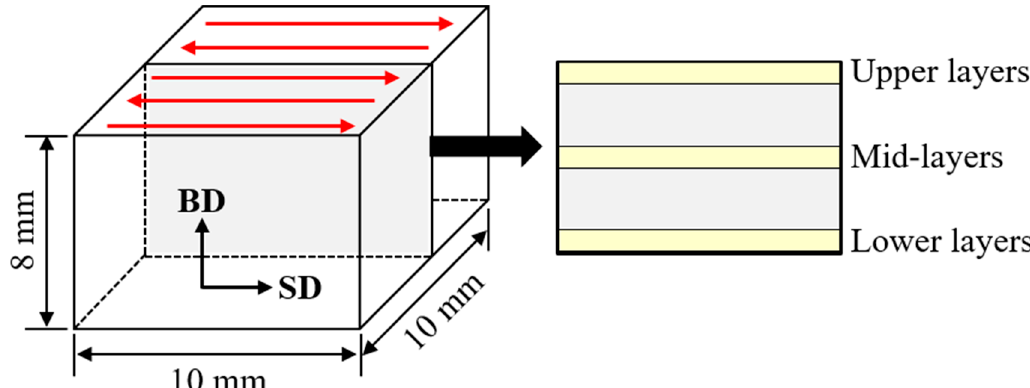
Figure 1. Additive manufacturing (AM) object by the selective laser melting process (SD: scan direction, BD: build direction, the scan pattern is indicated with the alternate arrows) [22] and its cross-sectional specimen for the microanalyses with the indicated sampled regions.